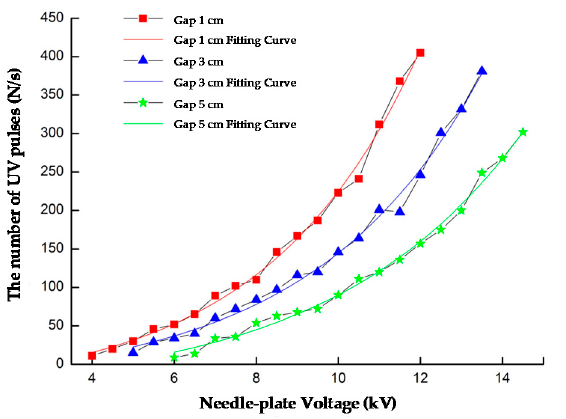
Figure 14. Needle-plate gap distance and the relationship between the number of UV pulses (L = 10 cm).